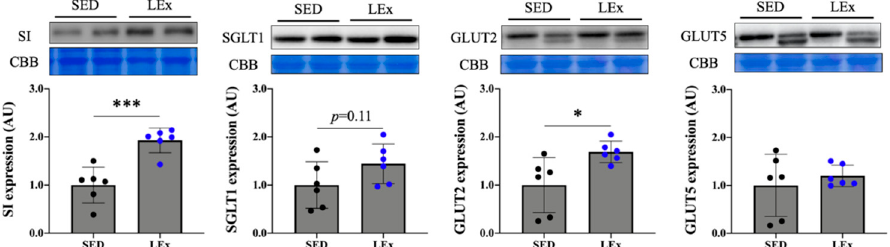
Figure 4. Effects of acute exercise on the expression of proteins related to carbohydrate absorption and digestion. *** p < 0.0005, * p < 0.05. SI: sucrase-isomaltase. SGLT1: Na+-dependent glucose transporter 1. GLUT2: glucose transporter 2. GLUT5: glucose transporter 5. CBB: Coomassie brilliant blue stain. To ensure equal protein loading across lanes, membranes were stained with CBB. The CBB bands represent the 35–48 kDa region where various internal controls are present. SED: sedentary group ( n = 6). LEx: low-intensity exercise group ( n = 6).